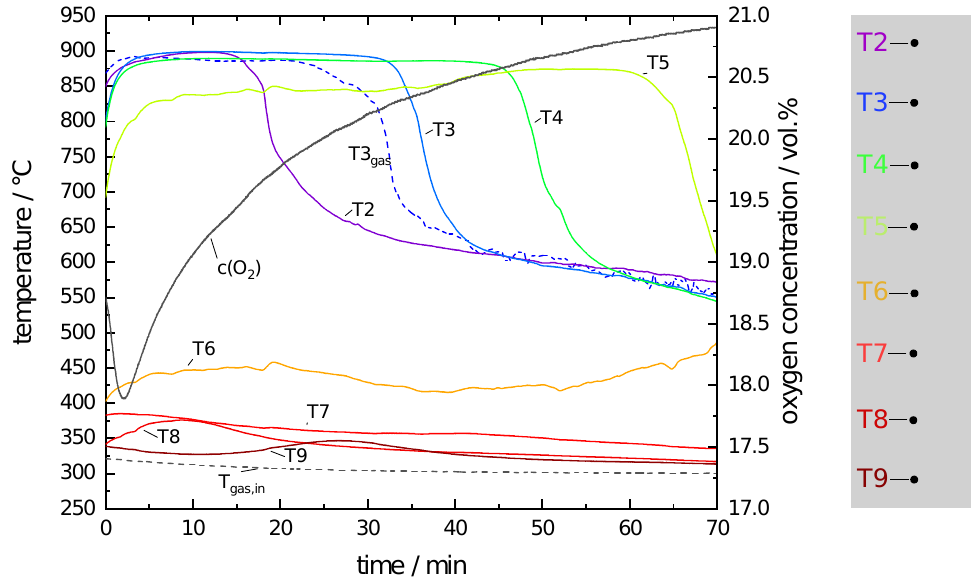
Figure 6. Solid (continuous line) and gas temperatures (dashed line) during moving bed operation with 3g/s particle flow in countercurrent to an air flow ˙ V n of 150l/min. The oxygen concentration in the exhaust gas is shown on the right axis of ordinate. The schematic of the oxidation section next to the diagram displays the temperature measurement